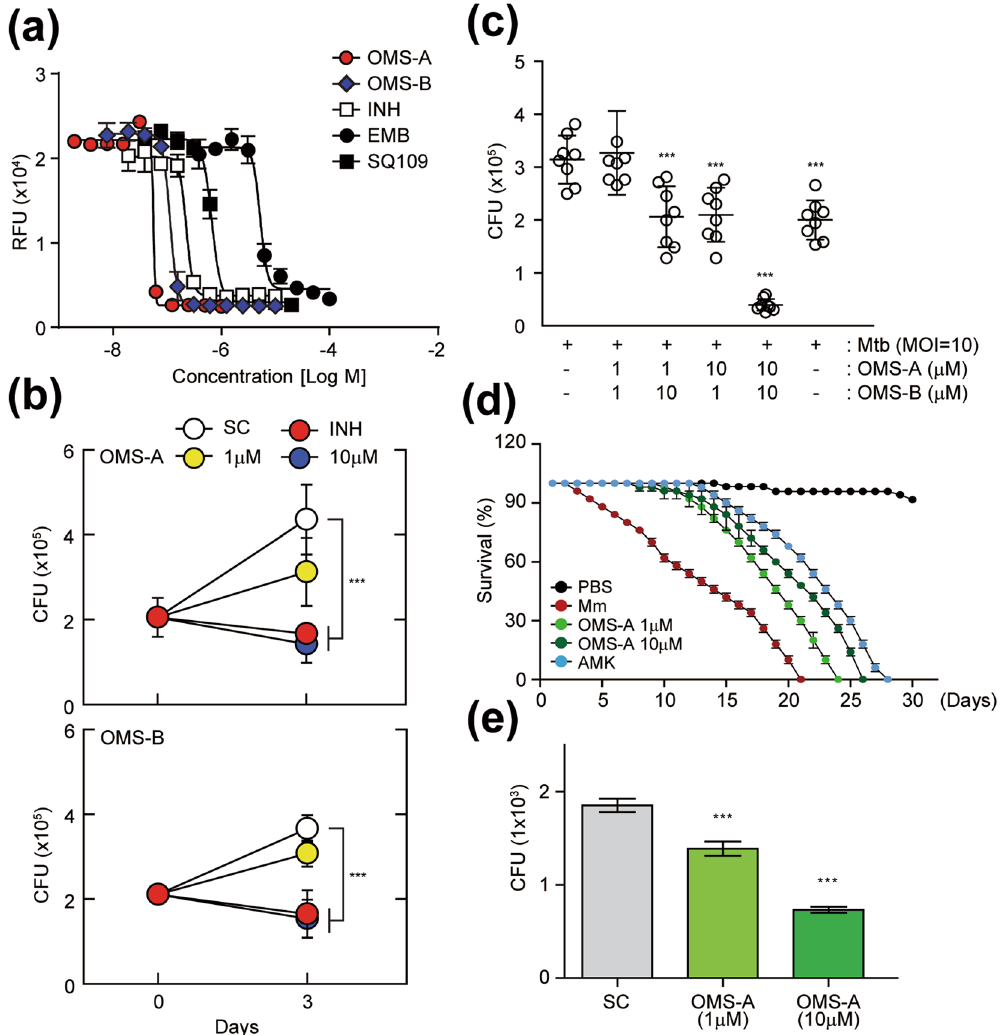
Figure 1. OMS shows antimycobacterial activity in vitro and in vivo . ( a ) Activity of OMS-A and OMS-B against Mtb replicating in culture broth medium. Mycobacterial growth was measured in relative fluorescence units (RFU). INH, EMB, and SQ-109 were used as positive controls. ( b ) BMDMs were infected with Mtb (moi = 10) for 4 h and then treated with OMS-A (1, 10 μ M; Top ), OMS-B (1, 10 μ M; Bottom ) or INH (0.5 μ g/ml). ( c ) BMDMs were infected with Mtb and then co-treated with OMS-A and OMS-B or INH. ( b and c ) After 3 days, intracellular bacterial loads were determined by CFU assay. ( d ) M. marinum (CFU = 500)-infected W 1118 flies were incubated with or without OMS-A (1, 10 μ M) and AMK (1 μ g/ml) medium. Dead flies were counted at 24 h intervals. The error bars indicate 95% confidence intervals. Log-rank analysis of the survival curves indicated that each group (n = 50) was significantly different. ( e ) W 1118 flies were injected with M. marinum and then incubated with or without OMS-A (10 μ M). After 12 days, each group (n = 20) of flies was harvested, homogenized, and quantified by CFU assay. All data represent the means ± SD of triplicates from each sample. *** p < 0.001, compared with Mtb-infected/untreated ( c ) and SC ( b , e ). INH, isoniazid; EMB, ethambutol; AMK, amikacin; SC, solvent